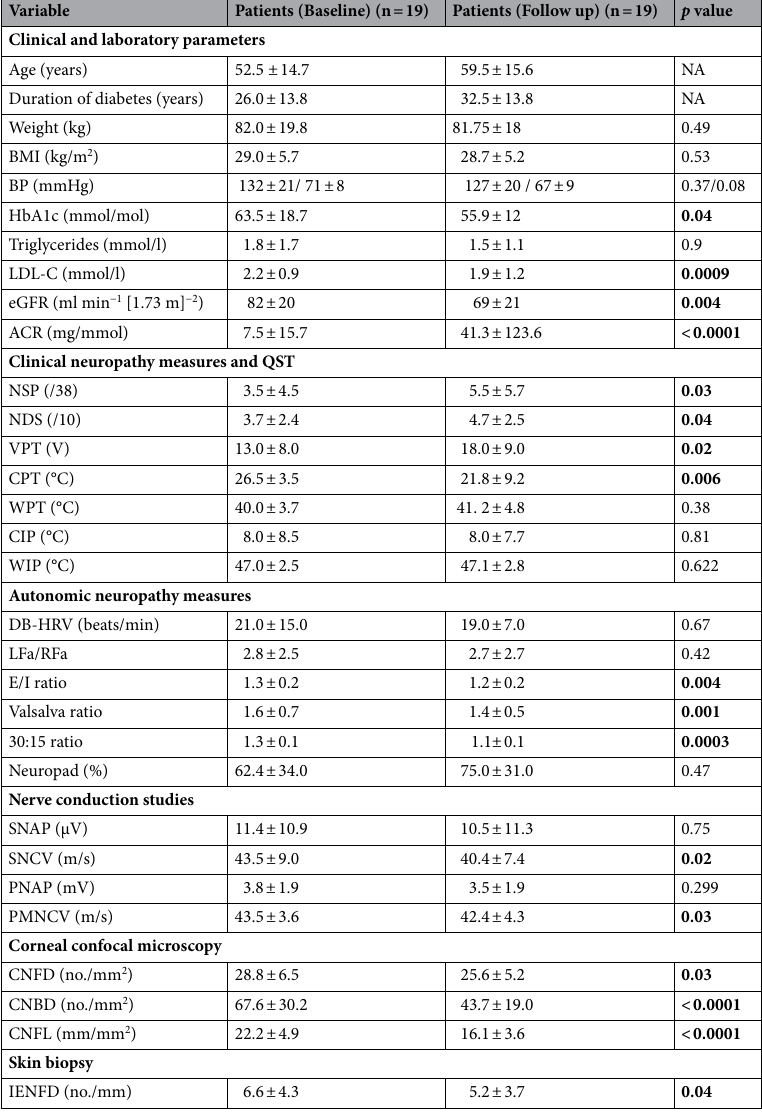
Table 2. Clinical and neuropathy parameters in patients at baseline and follow up. BMI—body mass index, BP—blood pressure, HbA1c—glycosylated haemoglobin, e GFR—estimated glomerular filtration rate,